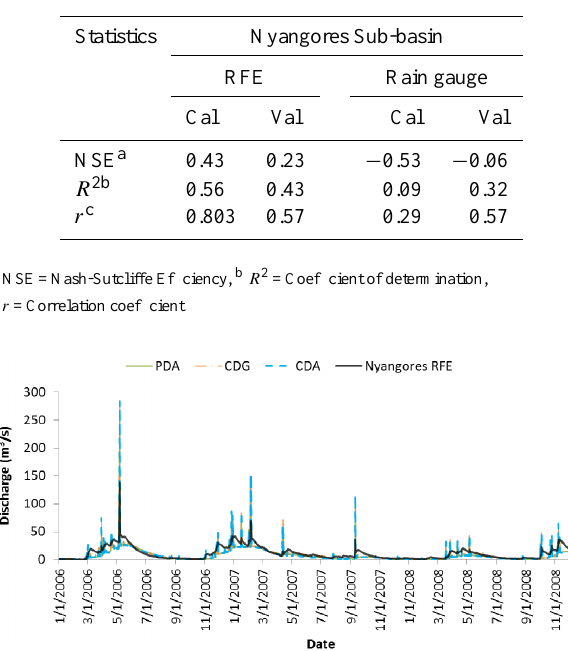
Figure 6. Nyangores River simulated daily discharge for land use scenarios. PDA = Partial Fig. 6. Nyangores River simulated daily discharge for land use Deforestation, Conversion to Agriculture, CDG = Complete Deforestation Conversion to scenarios. PDA=Partial Deforestation, Conversion to Agricul- Grassland, and CDA = Complete Deforestation Conversion to Agriculture. ture, CDG=Complete Deforestation Conversion to Grassland, and CDA=Complete Deforestation Conversion to Agriculture.